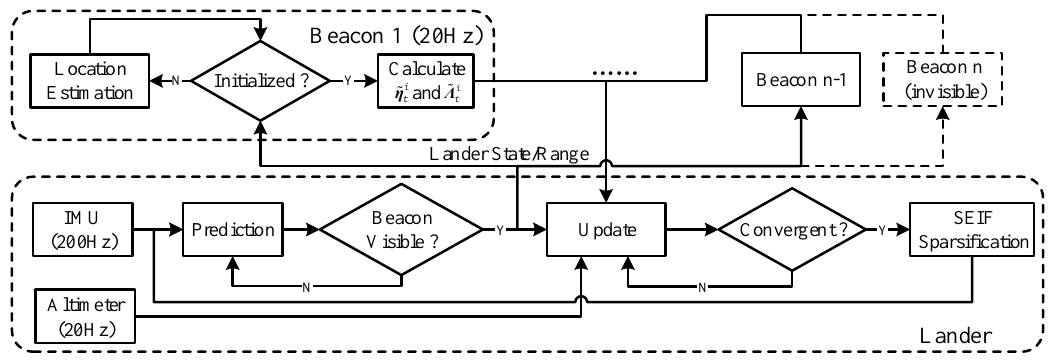
Figure 2. The flow diagram of the tightly-coupled navigation system based on the adaptive iterated sparse extended hybrid filter